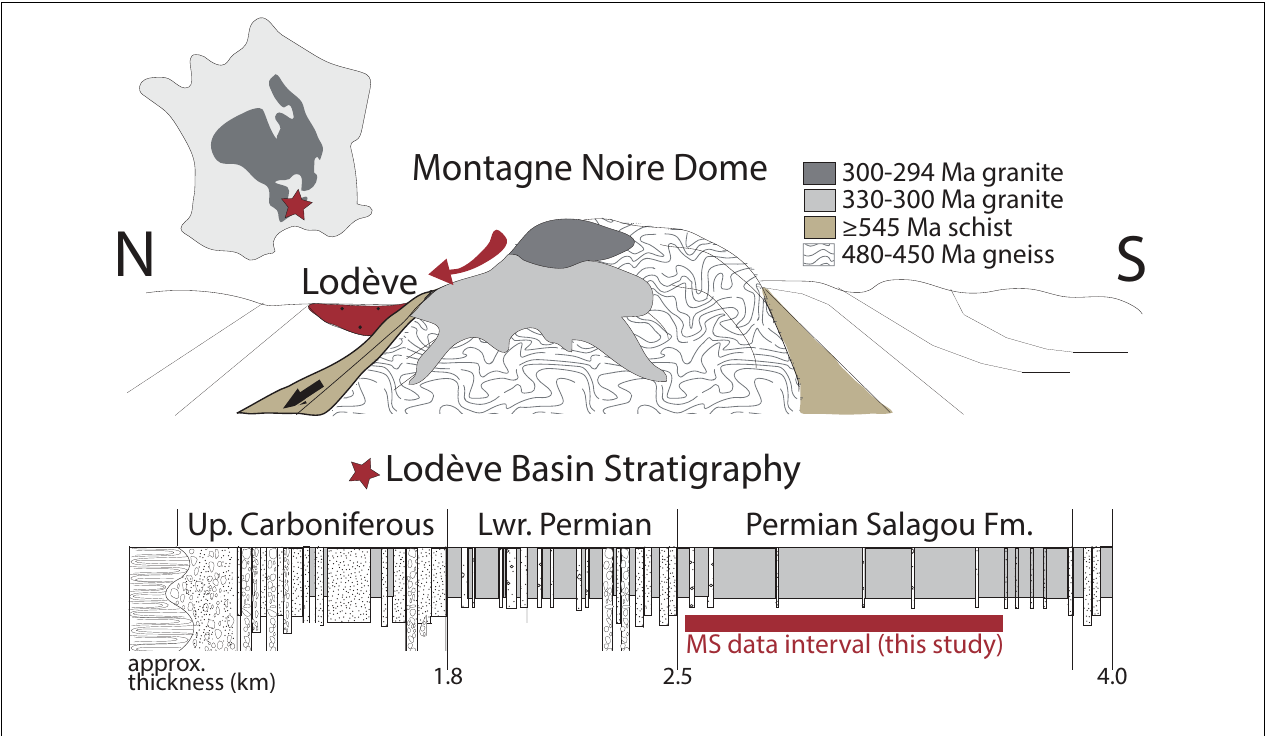
FIGURE 1 | Geological setting of the Lodève Basin in south-central France (southern Massif Central). The N-S cross section depicts the generalized position of the Lodève basin in relation to several source lithologies in the Montagne Noire Dome (interpreted source of sediment in the Lodève Basin; Pfeifer et al., 2016). The generalized stratigraphic column (adapted from Pochat and Van Den Driessche, 2011) of the upper Carboniferous – Permian strata in the Lodève Basin, depicting the stratigraphic interval of focus in this study with a red